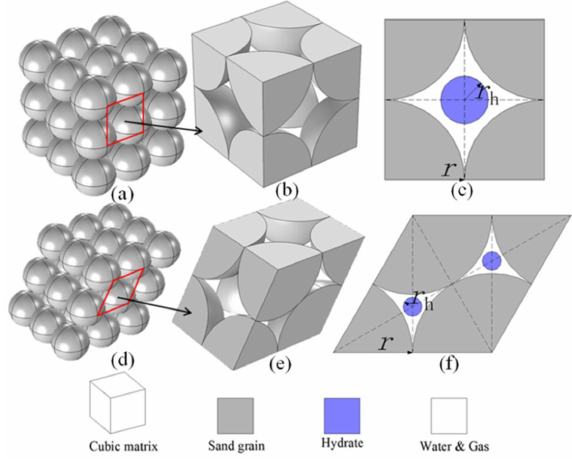
Figure 12. Simple cubic model and oblique cubic model of hydrate occupying pore centers reprinted from [100] with permission from Elsevier. ( a ) The simple cubic stacking structure; ( b ) the minimum cubic matrix of the simple cubic model; ( c ) a side view of the minimum cubic matrix of the simple cubic model with hydrate; ( d ) the oblique cubic stacking structure; ( e ) the minimum cubic matrix of the oblique cubic model; ( f ) a side view of the minimum cubic matrix the oblique cubic model with hydrate.